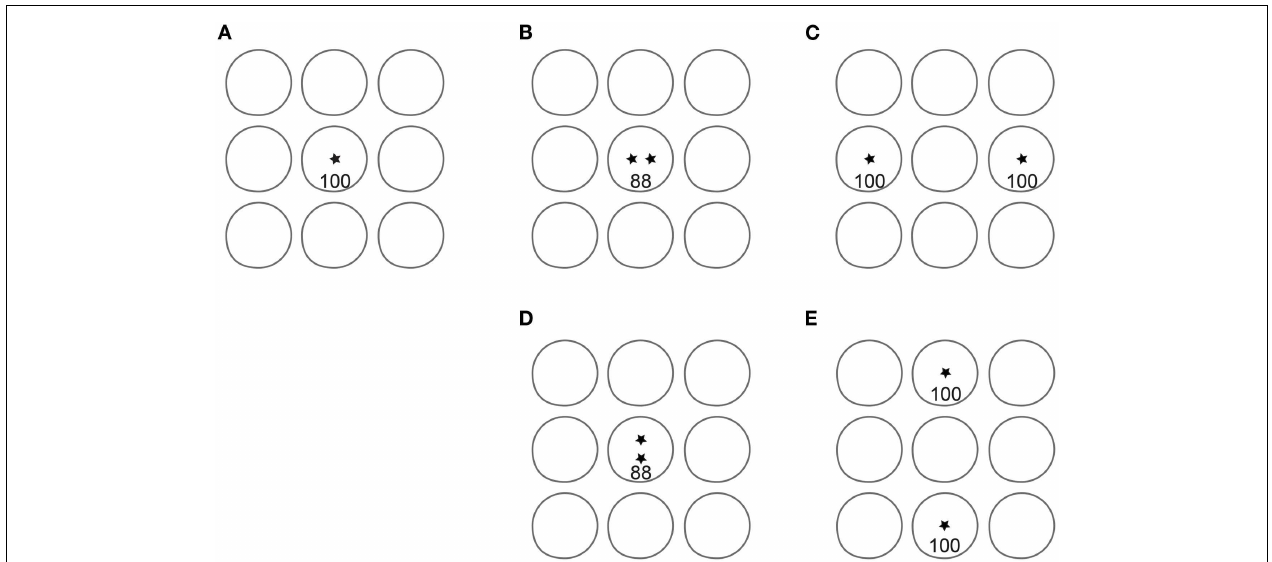
points can be perceived, because they fall within separate receptive fields (spatial cue). In addition, the magnitude cue has reversed direction, as the total number of action potentials in the two-point condition (200) is twice that in the one-point condition.Thus, the two-point task conveys spatial information at larger separations but is contaminated by a magnitude cue at all separations. In 2POD, the participant attempts to distinguish between two points separated horizontally and two points separated vertically by the same distance: (B) vs. (D) , or (C) vs. (E) .These stimuli evoke an equal number of action potentials, eliminating the magnitude cue and forcing the participant to rely on purely spatial information.When the points fall within a single receptive field, as in (B) and (D) , their orientation is indistinguishable. When the points fall within distinct receptive fields, as in (C) and (E) , their orientation is